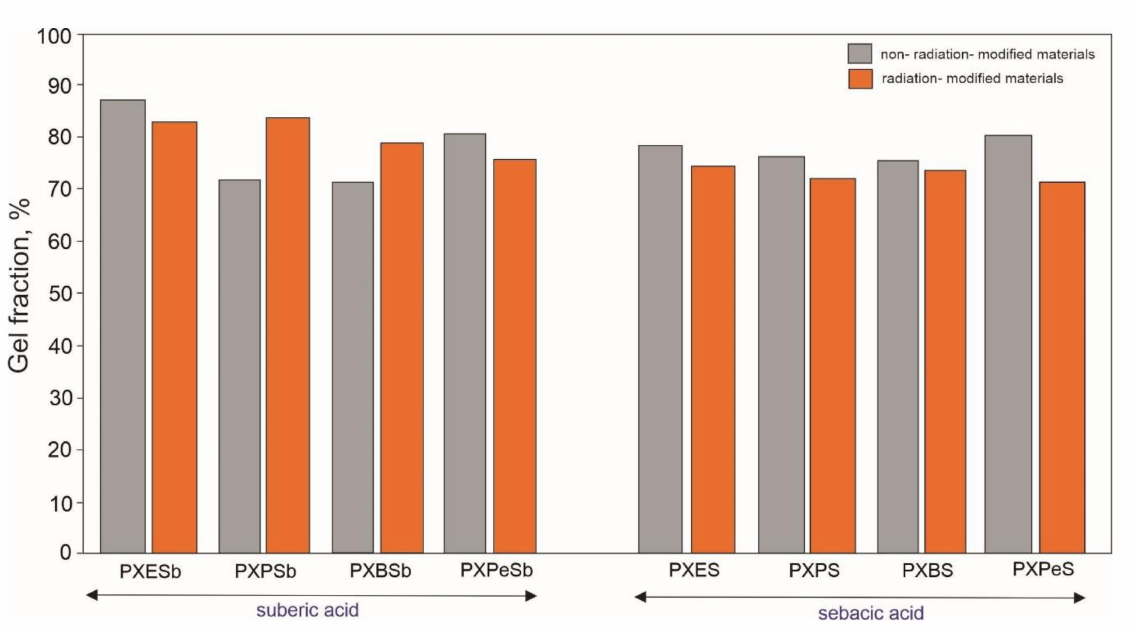
Figure 13. Gel fraction results for PXESb, PXPSb, PXBSb, PXPeSb and PXES, PXPS, PXBS, PXPeS non-radiation-modified materials (gray) and radiation-modified materials (orange).